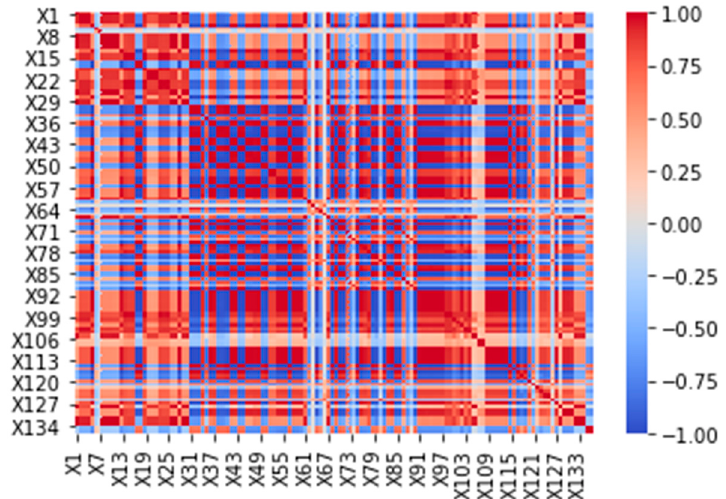
Figure 14. Wavelet denoising of the noisy data.